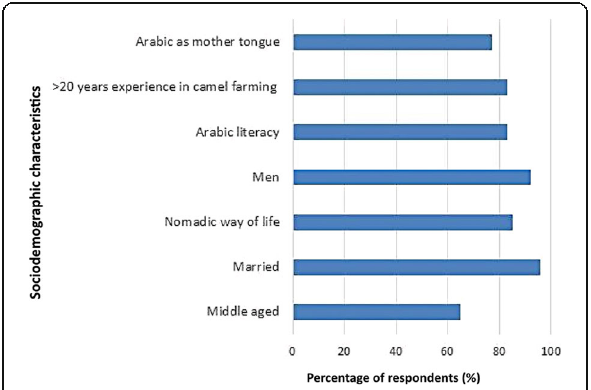
Figure 2 Socio-demographic characteristics of camel-owning peoples in Northeastern Nigeria